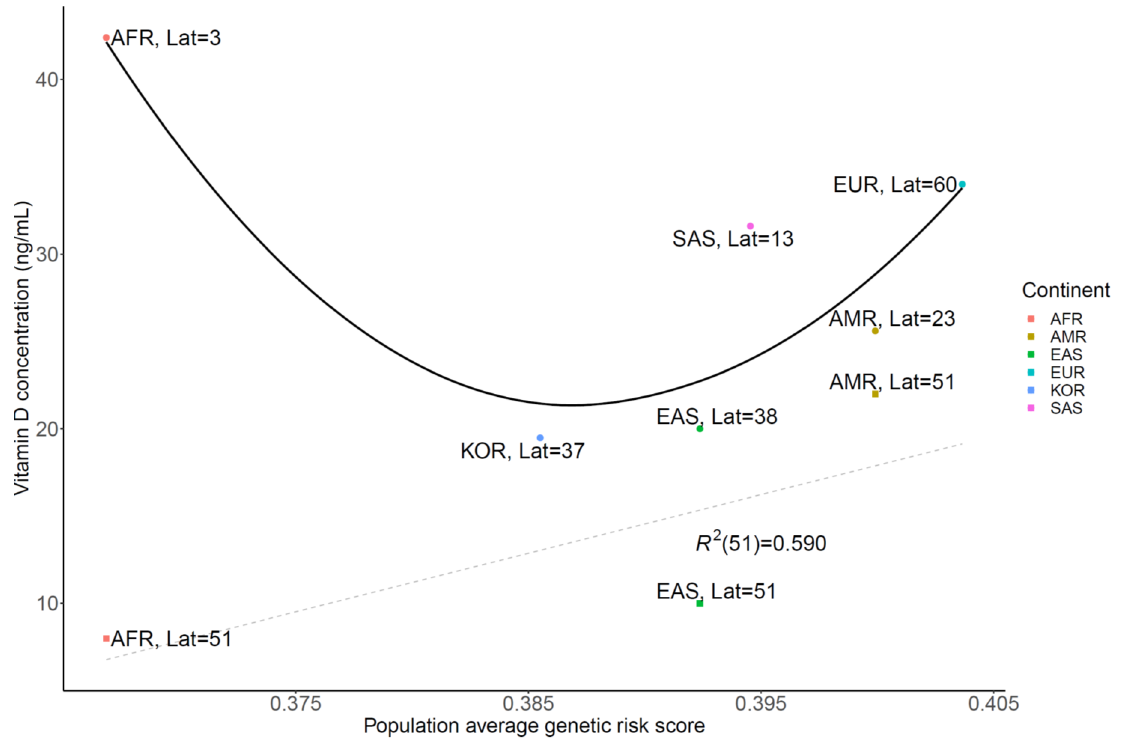
Figure 4. Correlation plot of vitamin D concentration and genetic risk score using related single-nucleotide polymorphisms, with latitude. Vitamin D concentration was strongly correlated with average genetic risk score at the same latitude ( R 2 = 0.590) in the grey dashed line. Its original endogenous population vitamin D concentration vs genetic risk score fitted in the black line. (Lat: Latitude, AMR: American, EUR: European, SAS: South Asian, AFR: African, EAS: East Asian).